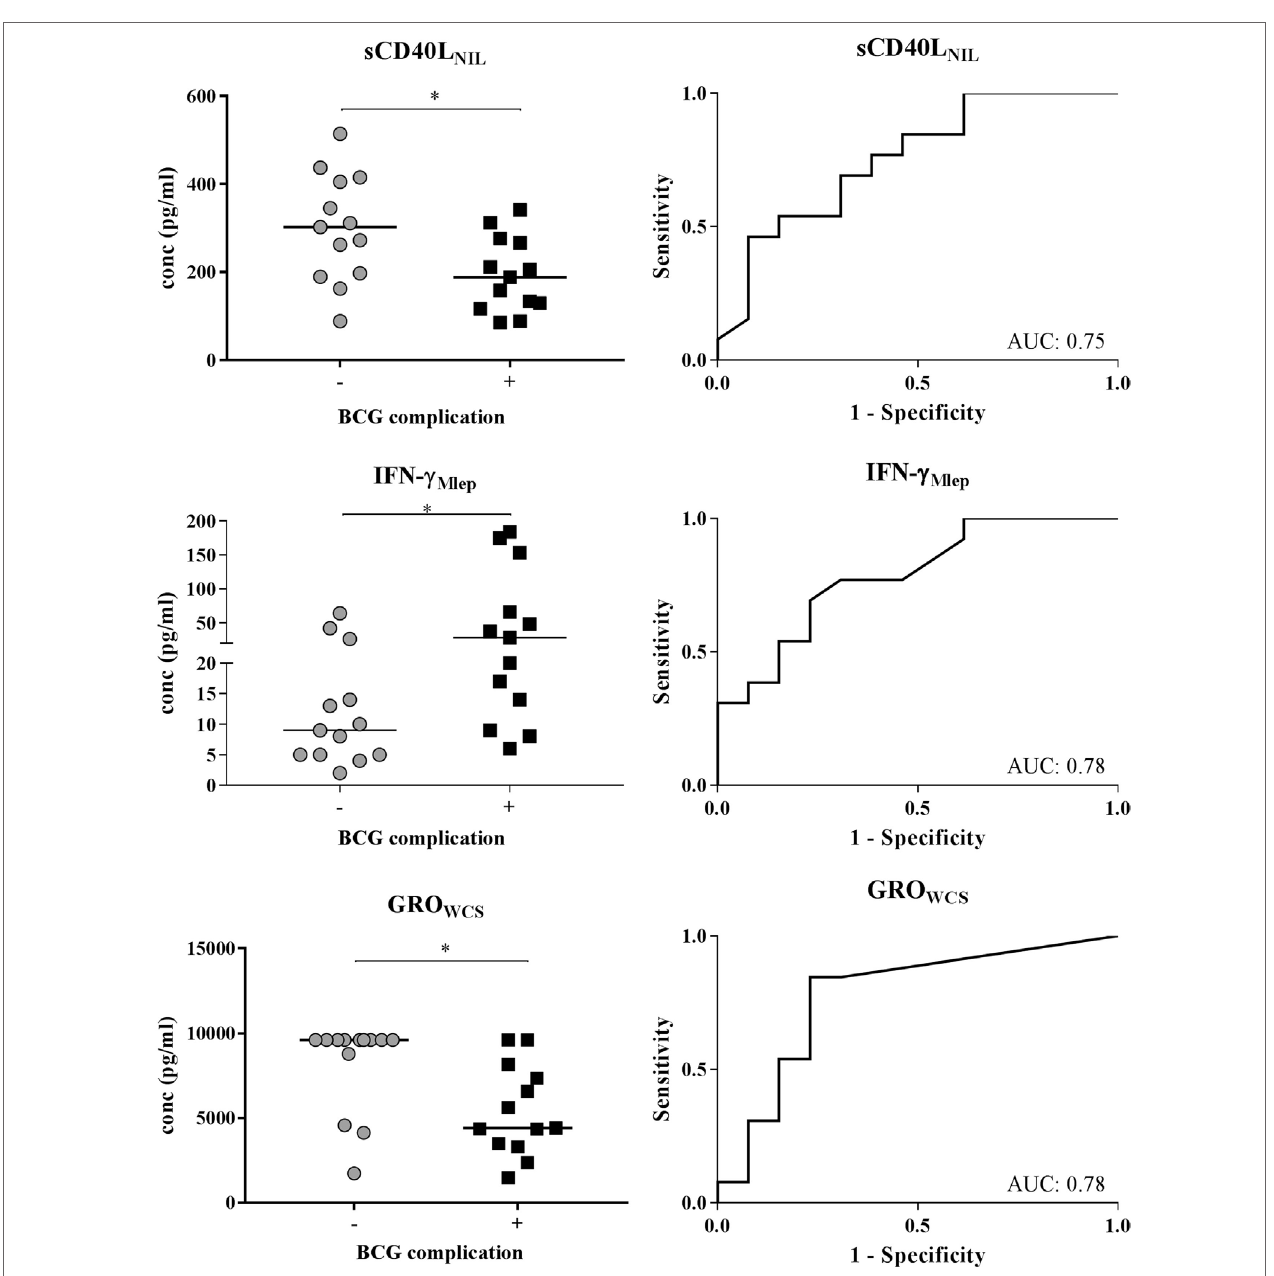
FiGUrE 3 | Cytokine concentrations in 24-h whole-blood assays (WBA) with or without stimulation with Mycobacterium leprae ( M. leprae ) unique proteins (Mlep) or M. leprae whole cell sonicate (WCS) in contacts with and without BCG complications (left panels). The global test (26) indicated that sCD40Lmed, GROwcs, and IFN- γ Mlep were significantly different between BCG-vaccinated contacts of leprosy patients with BCG-related complications and those without. This was confirmed by a Mann–Whitney U test. * p < 0.05–0.01. Receiver operating characteristic curves (ROCs) were computed and the area under the curve (AUC) is indicated for each analyte (right panels). The limits of detections for sCD40Lmed were 1.5–10,000, for GROwcs were 12.5–9,600. and IFN- γ Mlep were